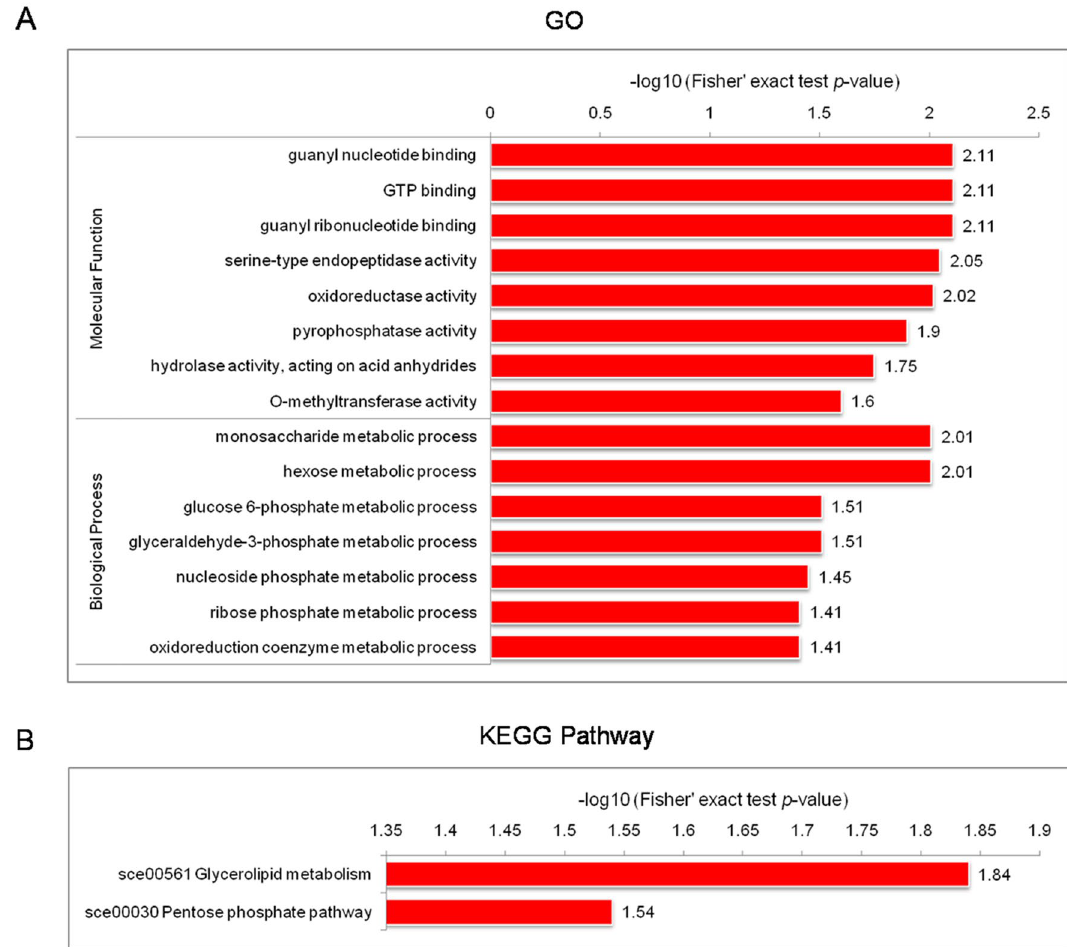
Figure 6. Enrichment analysis of up-regulated Kac proteins in C. chloroleuca 67–1. ( A ) GO-based enrichment analysis. ( B ) KEGG pathway-based enrichment